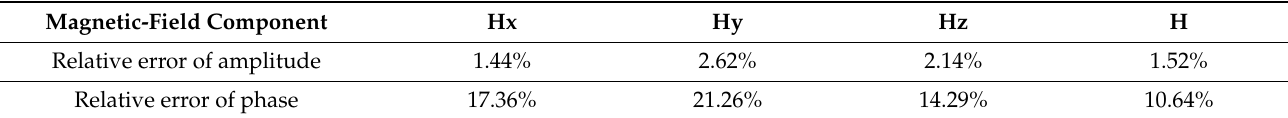
Table 3. Relative error of the magnetic field is obtained when 2193 data are used. Magnetic-Field Component